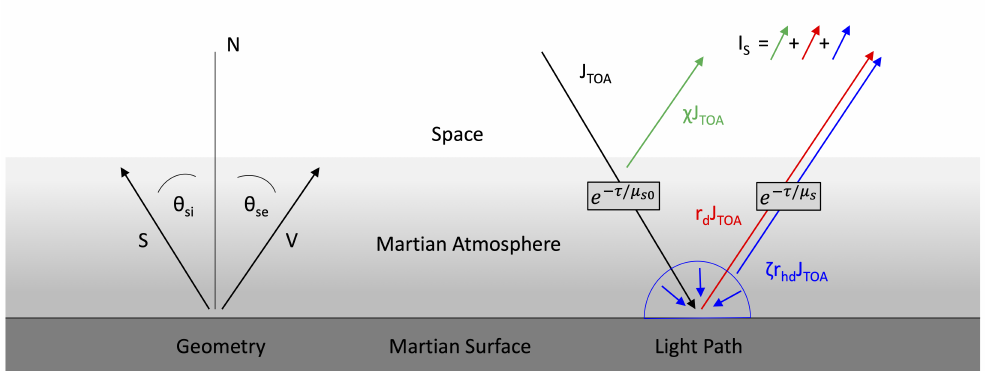
Figure 1. Scheme of the atmospheric model. Left : geometric definitions. Right : atmospheric